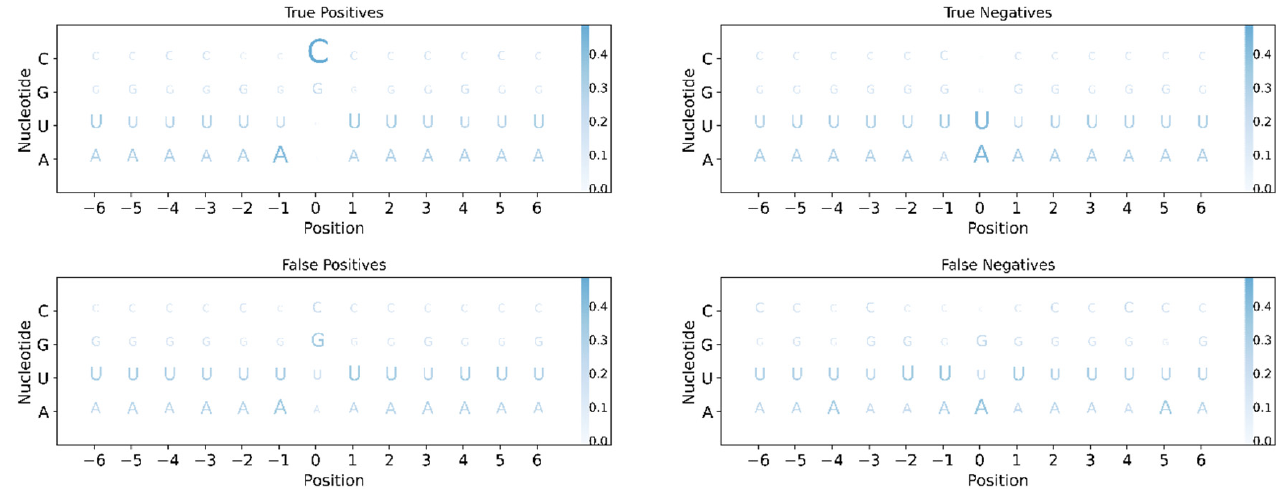
Figure 4. Logos of the true positives, true negatives, false positives, and false negatives when the NDRL threshold is 15. Each subplot shows the position on the horizontal axis and a row per nucleotide on the vertical axis. Each column/position for every subplot is normalized vertically, so they add up to 1. The intensity of the blue correlates with the size of each letter, so a more frequent nucleotide appears in a darker blue and a larger letter size.